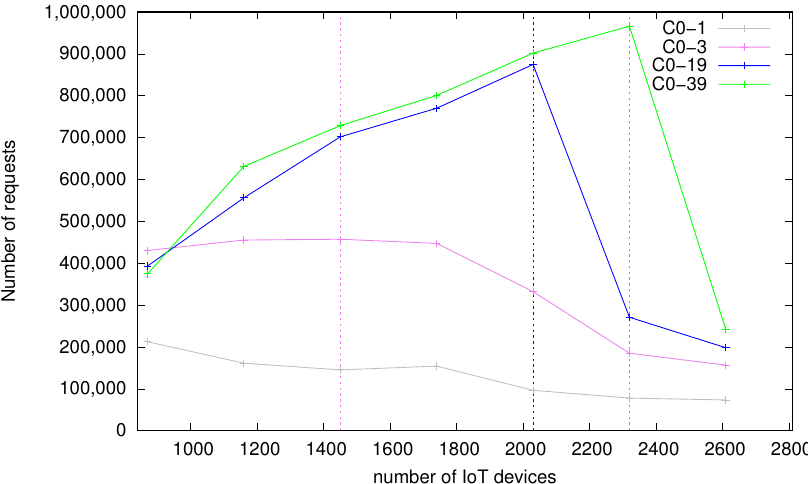
Figure 3. Number of successfully processed